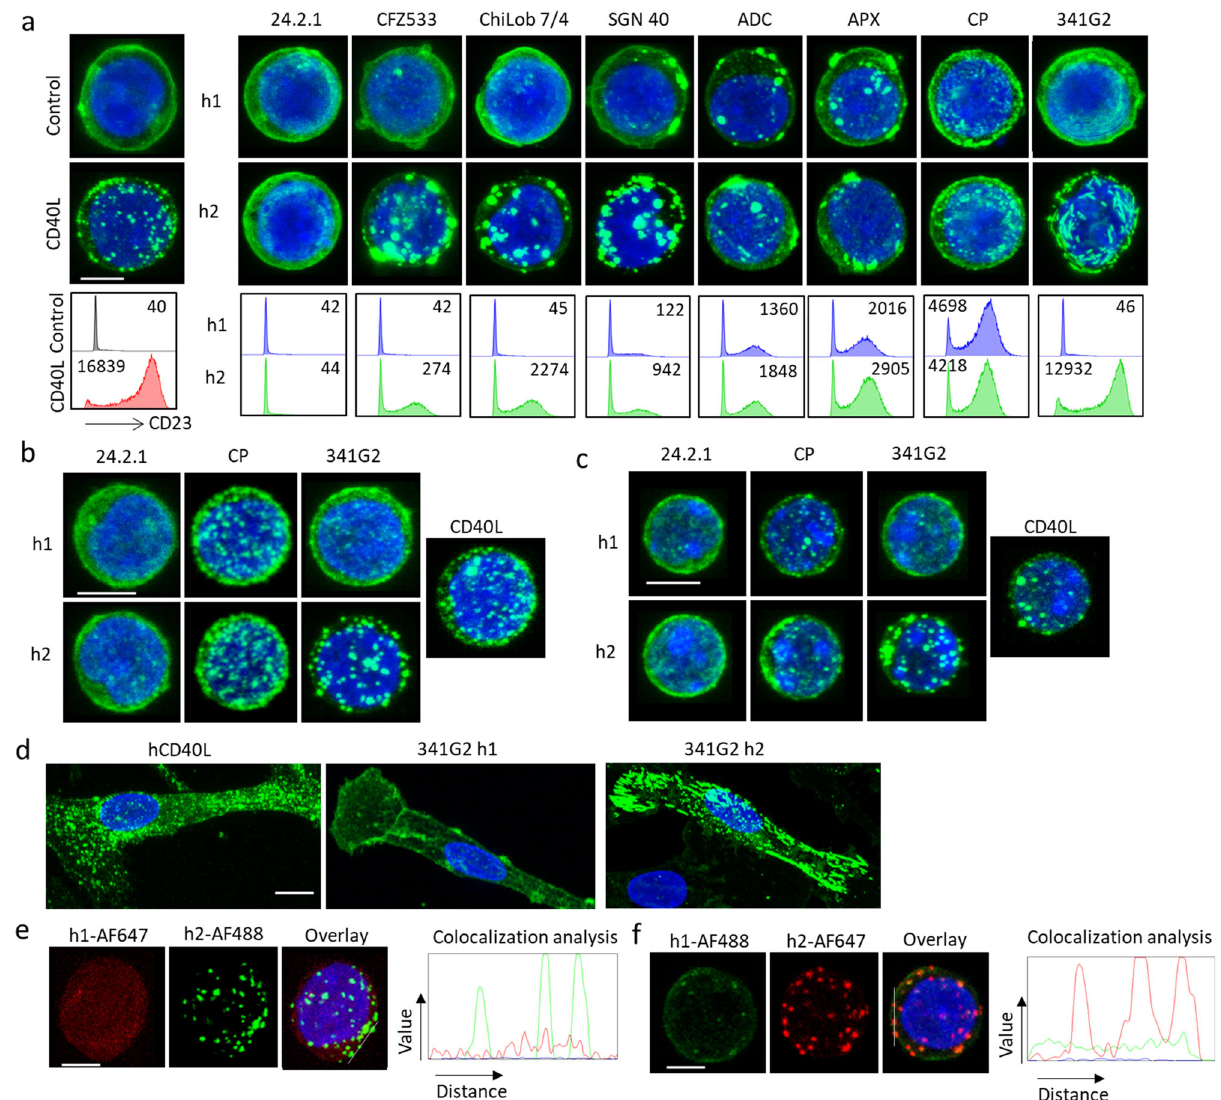
Fig. 1 CD40 agonists induce differential CD40 clustering. a Upper panels: Jurkat-hCD40ECD-GFP cells were treated with 10 µ g/mL anti-CD40 mAbs of either hIgG1 (h1) or hIgG2 (h2) isotype as indicated for 1 h, and then fi xed with methanol, nucleus stained with DAPI and imaged using a Leica SP8